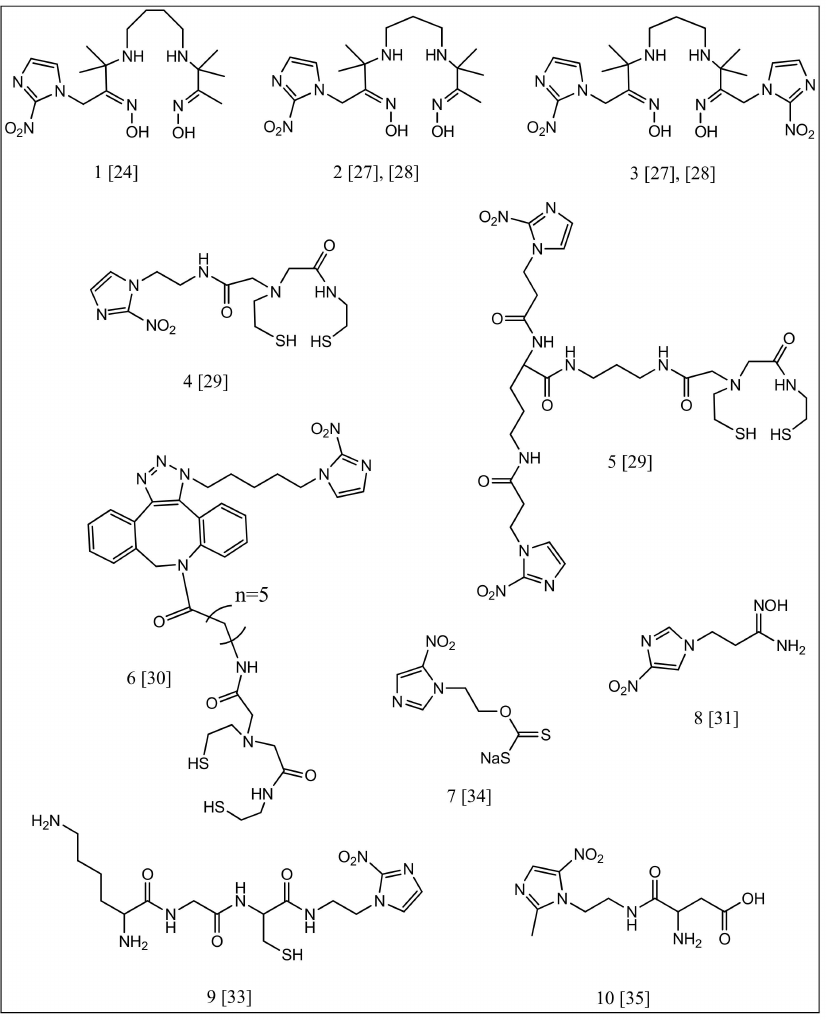
Figure 4. Structure of various nitroimidazole derivatives proposed for the preparation of potential [ 99m Tc(V)O] 3 + hypoxia targeting agents